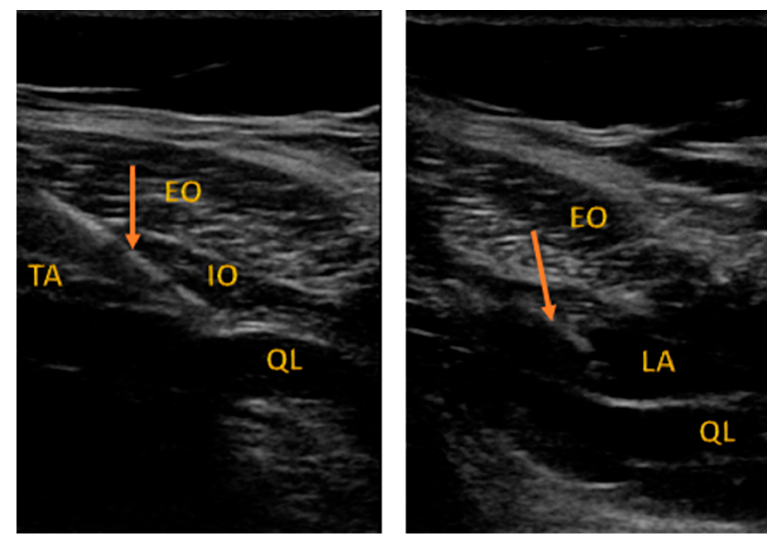
Figure 1. Sonoanatomy of QLB performed in the study.